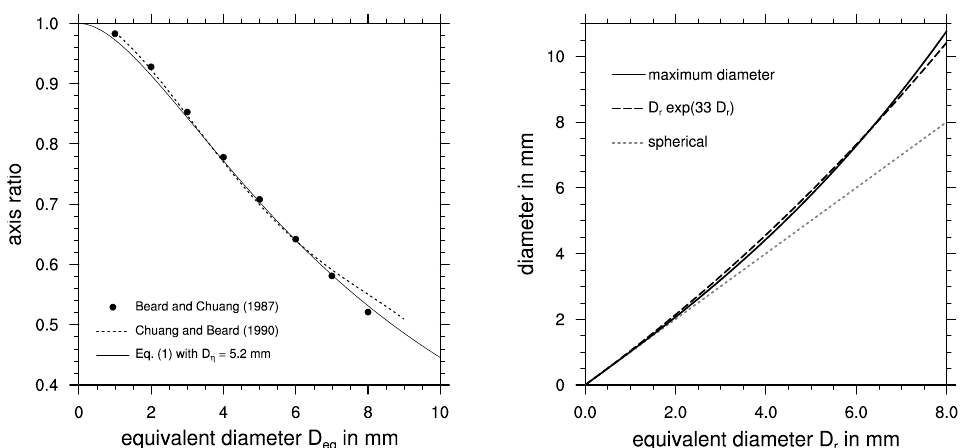
Fig. 1. Parameterization relations for non-spherical geometry of raindrops. The axis ratio as a function of equivalent diameter (left) following from Eq. (2) with D η = 5 . 2mm, the results of the Beard and Chuang (1987) model and the polynomial fit of Chuang and Beard (1990). For the maximum diameter as a function of the equivalent diameter (right) the explicit relation D r, max = D r exp (ω r D r ) , with ω r = 33m − 1 , is used as an approximation to the implicit relation given by Eq. (2).